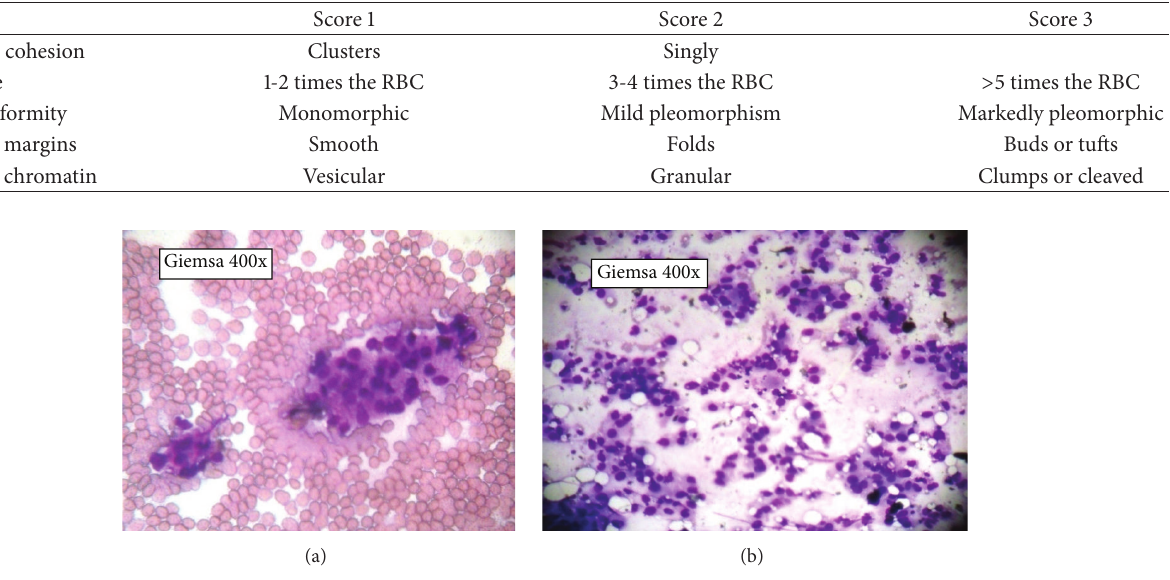
Table 2: Robinson’s grading system.